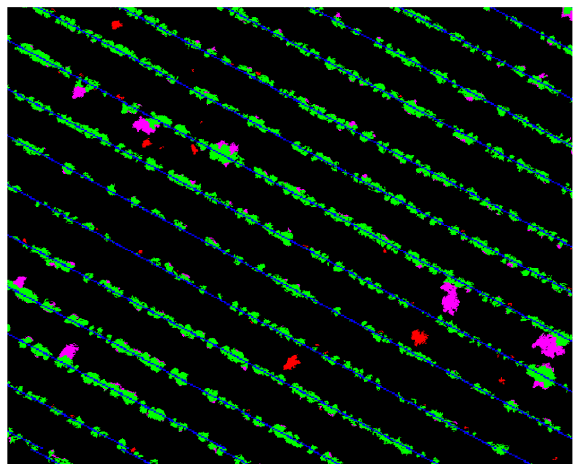
Figure 5. Detection of inter-row weeds (red) after line detection (blue) in a bean image. The crop mask is represented in green and the potential weeds in